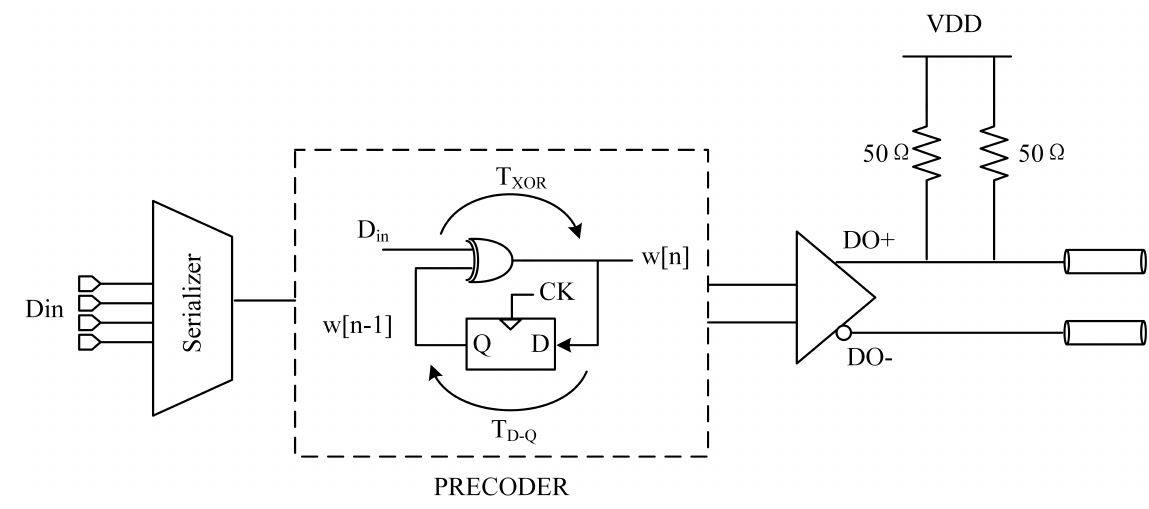
Figure 3. Traditional precoding structure diagram.